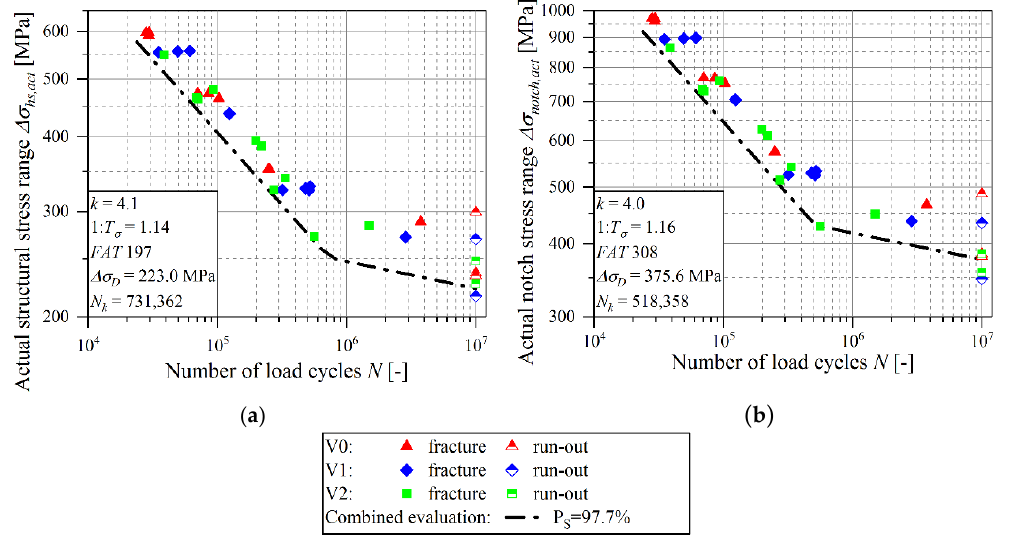
Figure 19. Resulting S/N-curves with consideration of specimen distortion. ( a ) Actual structural stress; ( b ) Actual notch stress.